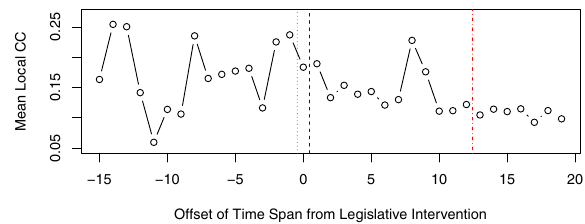
Fig. 4 Mean number of partners and mean transactions per actor. Temporal representation of the mean number of partners (circles) and mean transactions per actor (diamonds) for 30-day spans. After the fi rst year of life of the project, the mean number of transactions per agent decrease, then, with the tax-incentives (span 0), there is a new increasing trend that stabilized at around fi ve transactions per agent per 30-day. The numbers of partners stay steady before and after the tax-incentives, around 2.4.